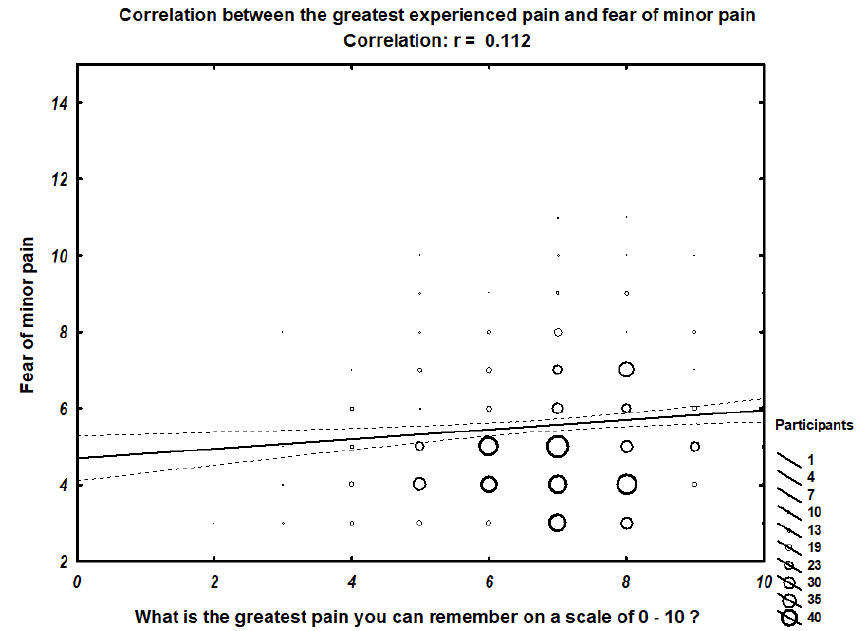
Figure 1. Correlation between the greatest experienced pain and fear of minor